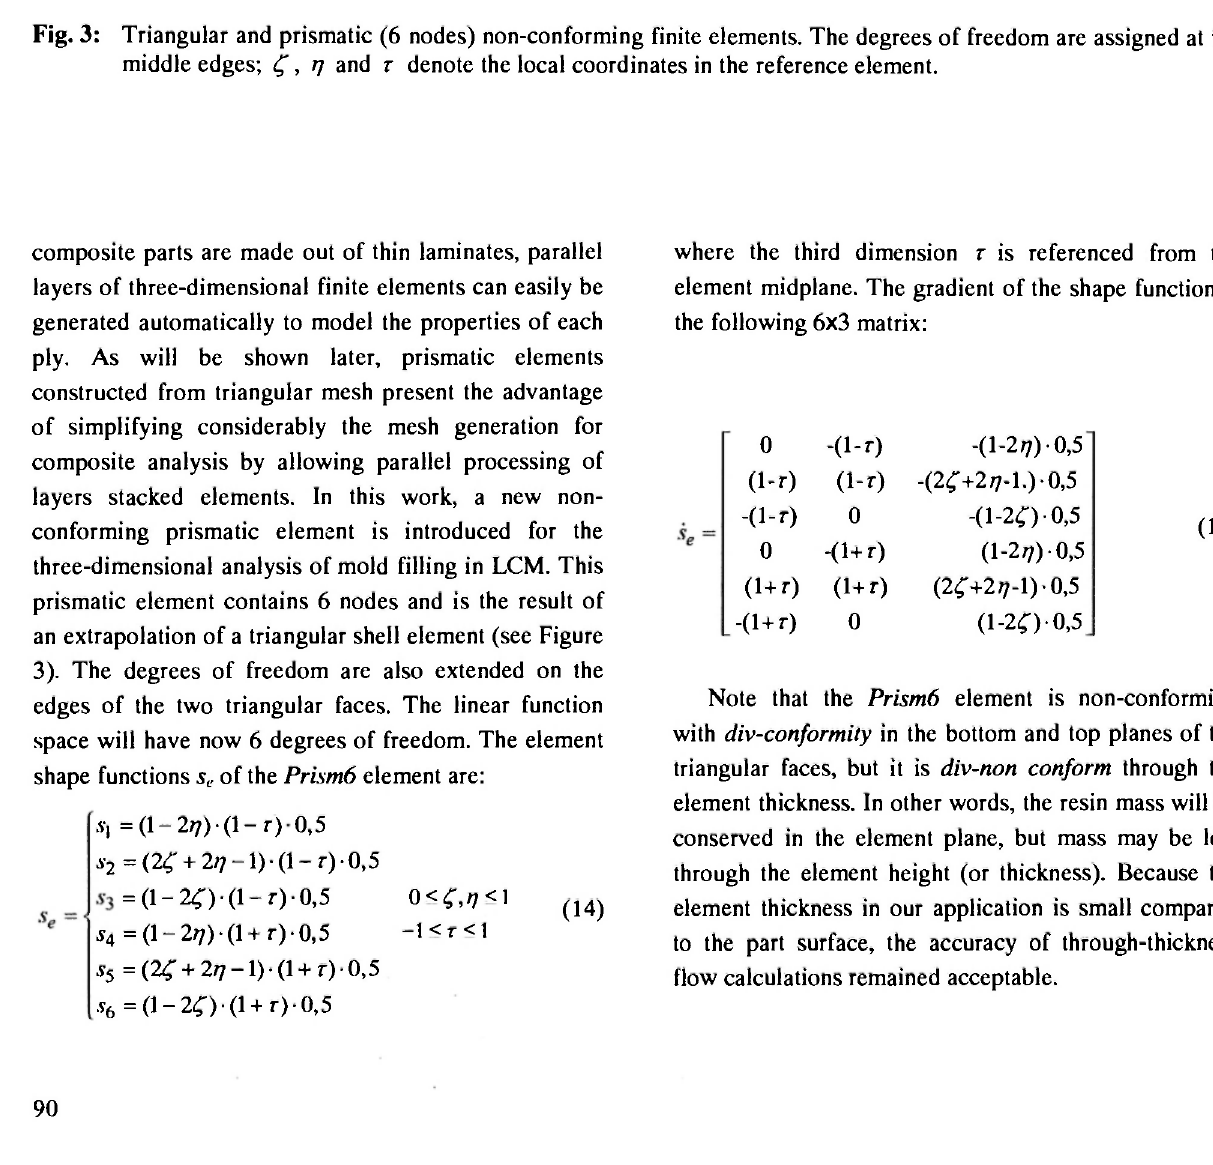
Fig. 3: Triangular and prismatic (6 nodes) non-conforming finite elements. The degrees of freedom are assigned at the middle edges; ζ, η and τ denote the local coordinates in the reference